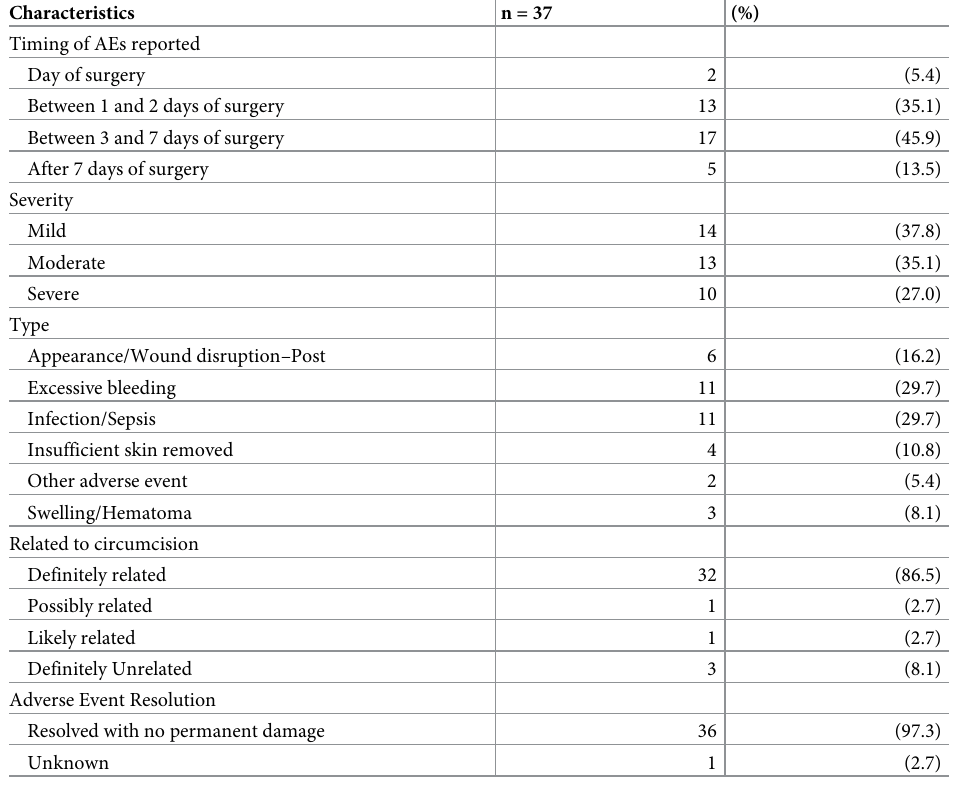
Table 2. Description of adverse events (AEs) reported post-surgery in adult men in North West and Gauteng provinces of South Africa (May 2013 –December 2014) (n = 7,864).